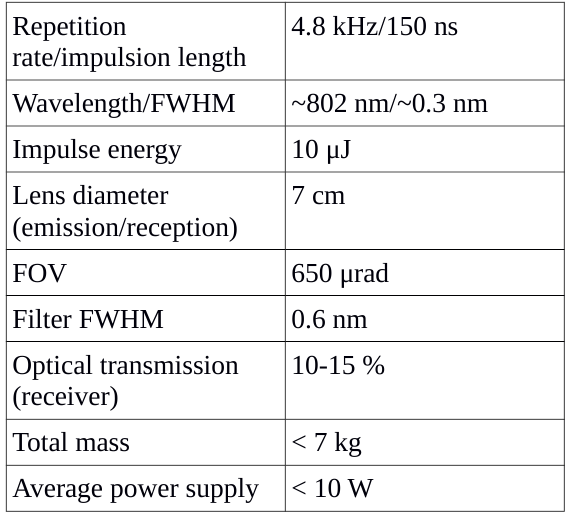
Tab.1 Main characteristics of the balloon-borne lidar BeCOOL